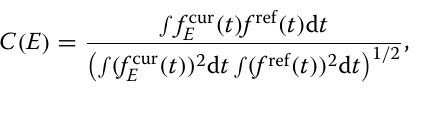
d V / V where E ( = − ) is the relative velocity change with respect to the reference trace and C ( E ) is the cross-cor- relation coefficient between the reference trace and the stretched version of the current trace. We estimated the relative velocity change E that maximizes C ( E ) by apply- ing a grid search algorithm that searched E in the range 0.025 < E < 0.025 with a step size of 0.0005. We further − applied a ternary search algorithm to increase the resolu- tion of E values. We used 100 s of coda waves to obtain velocity changes by the stretching interpolation. The starting time of coda waves was defined as t coda d / v min , = where d is the distance between a station pair and v min is the minimum apparent velocity between the stations. As v min , we used a relatively slow velocity of 1 km/s to select coda